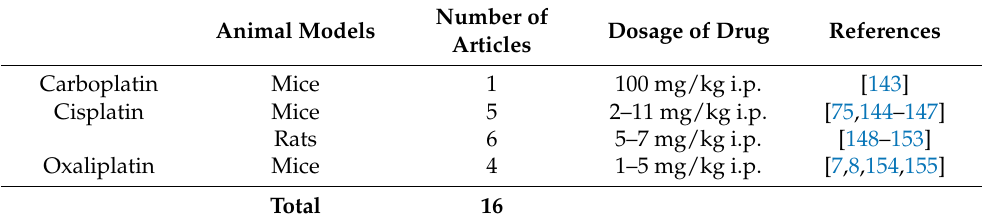
Table 3. Summary of data collected from in vivo animal studies involving platinum-based chemother- apy drugs-induced intestinal mucositis. Drug concentrations obtained from studies are listed in a range of minimum to maximum dosage administered in animal models.